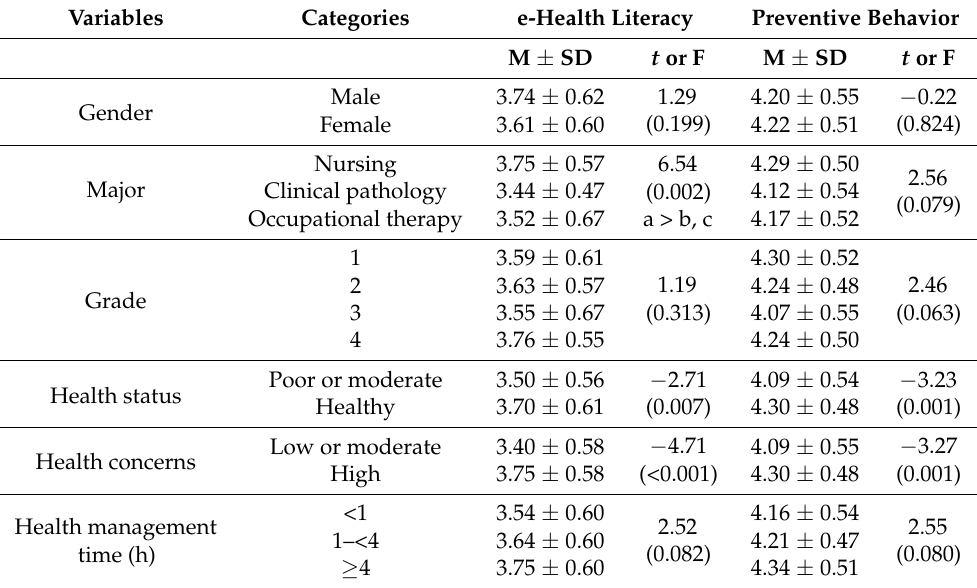
Table 2. Differences of e-HL and infection-preventive behaviors according to the participants’ general